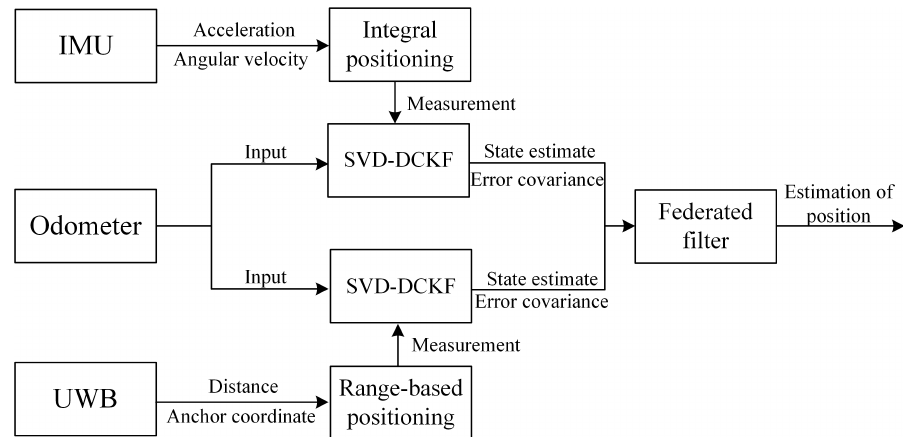
Figure 2. Inertial measurement unit and ultra-wide band signal (IMU-UWB) indoor positioning via the Singular Value Decomposition (SVD)-federated derivative cubature Kalman filter (FDCKF).